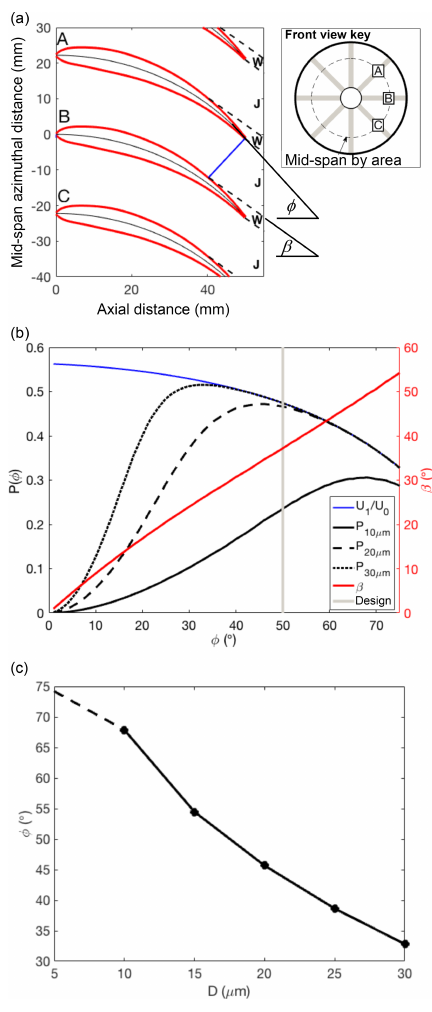
Figure 2. Optimization of stator blade angles. (a) Schematic of blade geometry and associated wake (W) and jet (J) structure, (b) stator performance as a function of blade angle (see text for de- tails), and (c) optimum blade angle using method shown in panel (b) calculated over a range of droplet diameters (dashed line indicates low confidence of applicability of theoretical